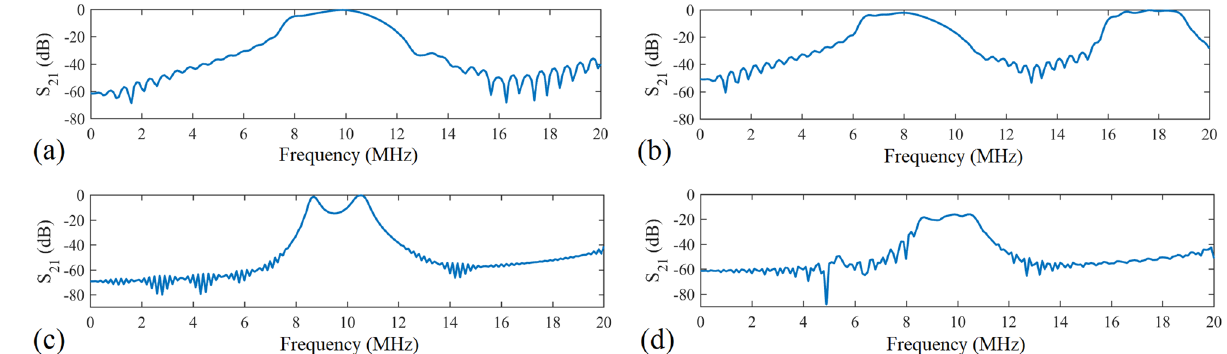
Figure 7. Electromagnetic simulation results. ( a ) S 21 of five activated units. ( b ) S 21 of five inactive units. ( c ) S 21 of activated units 1, 2, 4, 5 and an inactive unit 3. ( d ) S 21 of activated units 1, 4, 5 and inactive units 2,